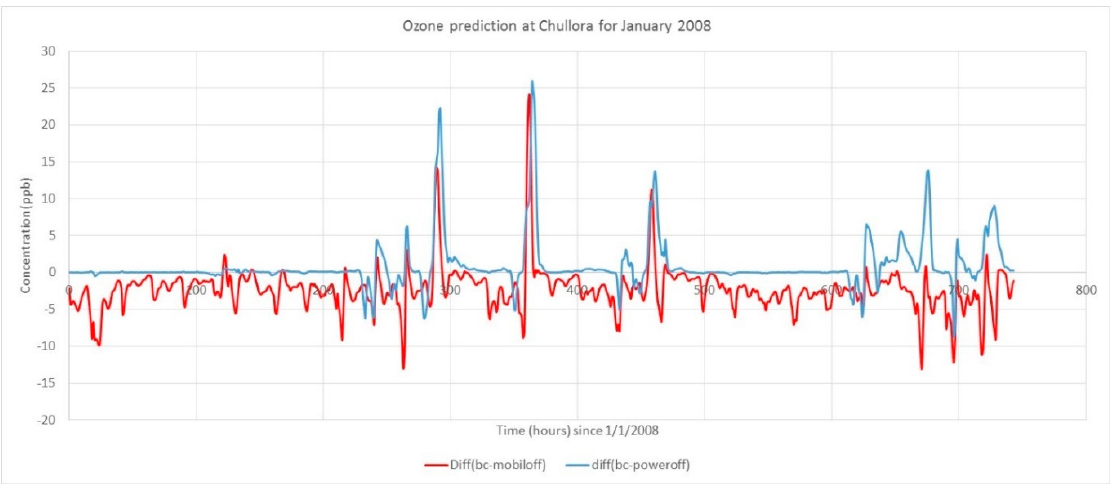
Figure 11. Time series of difference in predicted 1-h ozone (ppb) at Chullora for January 2008 between the base case and motor vehicle emissions off (red) and between the base case and power station emissions off (blue).